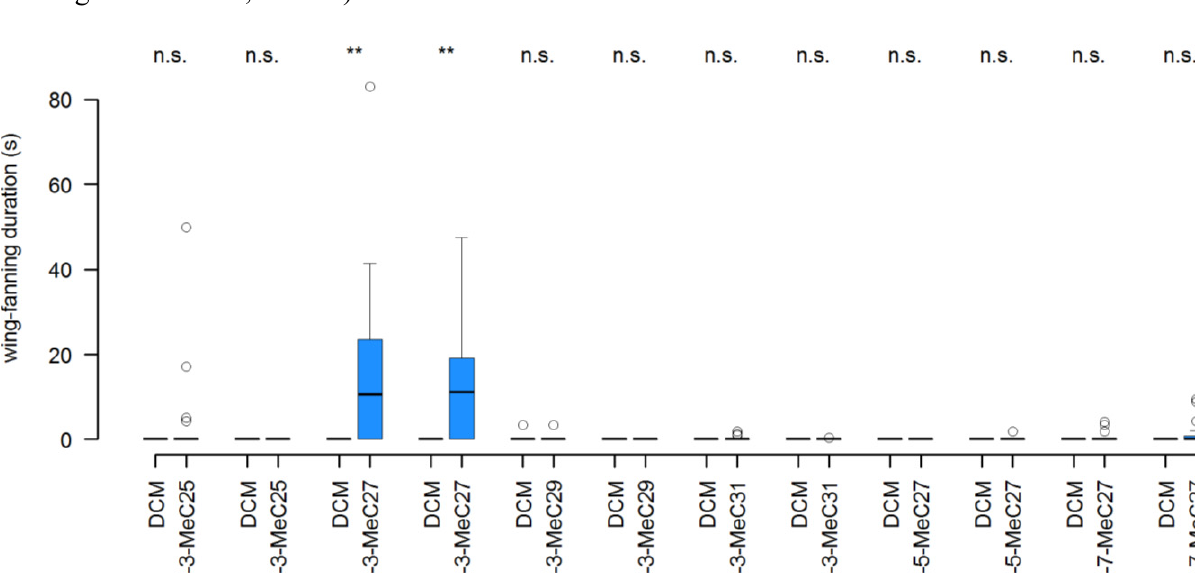
Figure 3. Restoration of pheromone activity in 4-d-old male dummies (Experiment 1). Wing-fanning duration during a 5-min observation period performed by L. distinguendus responder males towards 4-d-old male dummies treated with dichloromethane (DCM, control = white) and with 150 ng of different methyl-branched alkanes in dichloromethane, respectively (blue). Box-and-whisker plots show median (horizontal line), 25 (cid:177) 75 percent quartiles (box), maximum/minimum range (whiskers) and outliers (>1.5× above box height). Asterisks indicate significant differences between a methylalkane treatment and the corresponding DCM control ( p > 0.05 = non-significant (n.s.), p < 0.01 = ** , Wilcoxon signed rank test; N =